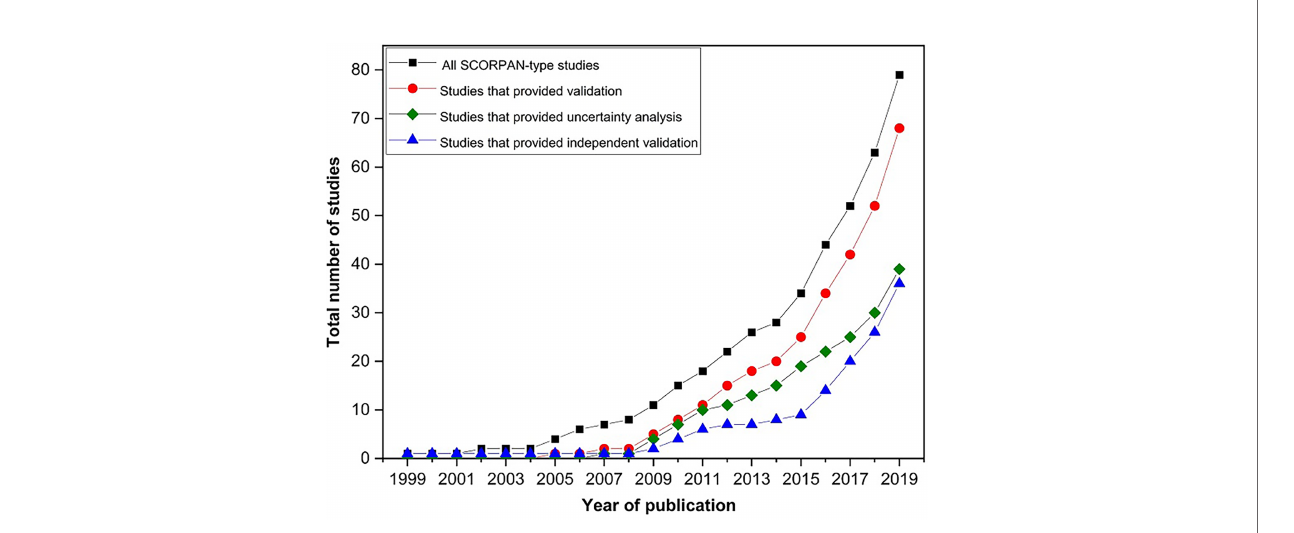
FIGURE 1 | Change of the total number of SCORPAN-type regional and national studies included in this review on soil organic C quanti fi cation from agricultural lands during a 20-year time period. The studies were also regrouped based on whether they carried out validation, independent validation, and uncertainty